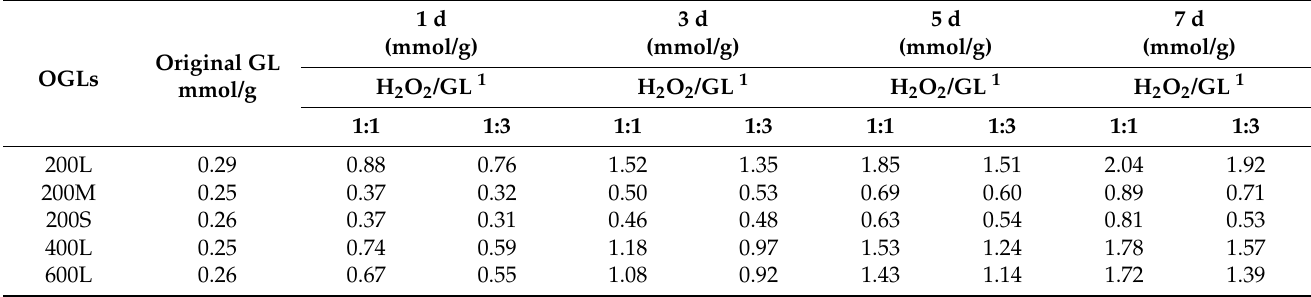
Table 5. Carboxy group content of OGLs determined through potentiometric